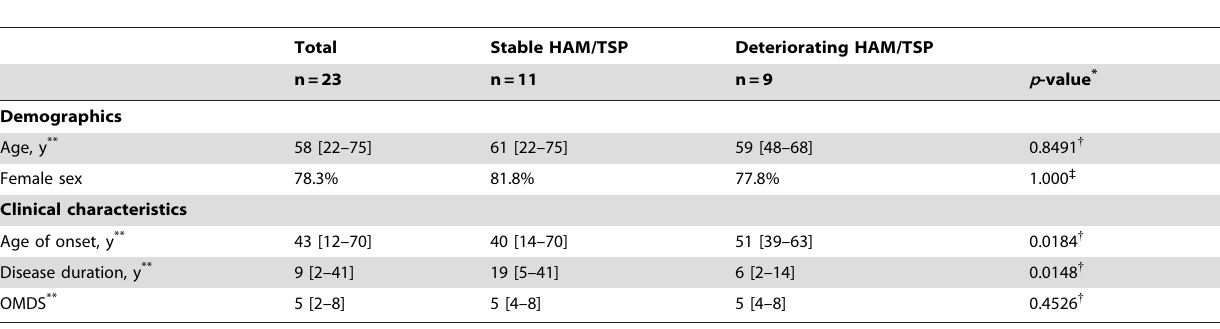
Table 3. Demographics and clinical characteristics of HAM/TSP patients (Test